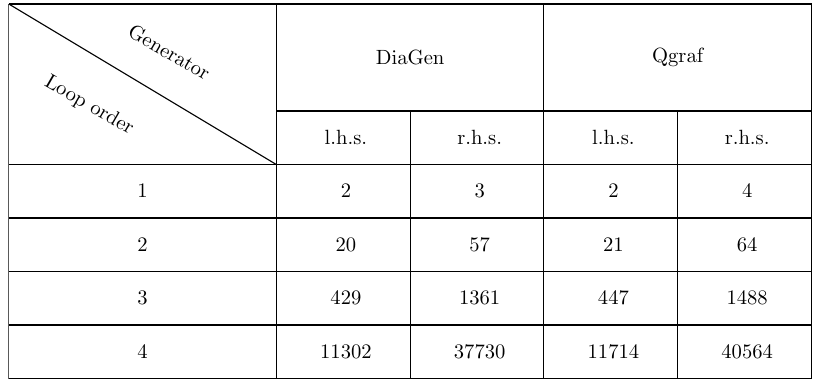
Table 1 . Numbers of Feynman diagrams up to 4-loop order generated by the generators Dia- Gen and QGRAF . Sample diagrams to 3-loop and at 4-loop are shown in figures 3 and 4, respectively.